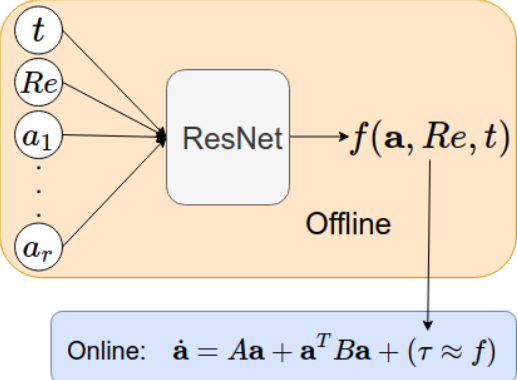
Figure 1. Flow chart of the new